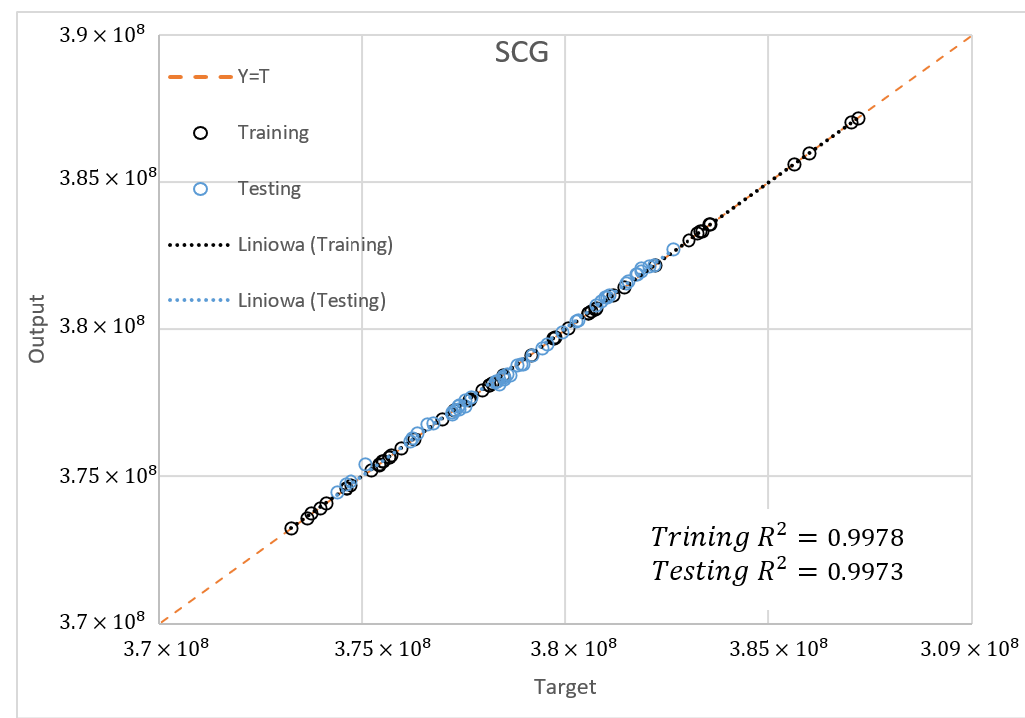
Figure 23. Comparison of data matching used for training and validation for the SCG algorithm (NN 20-2-1).